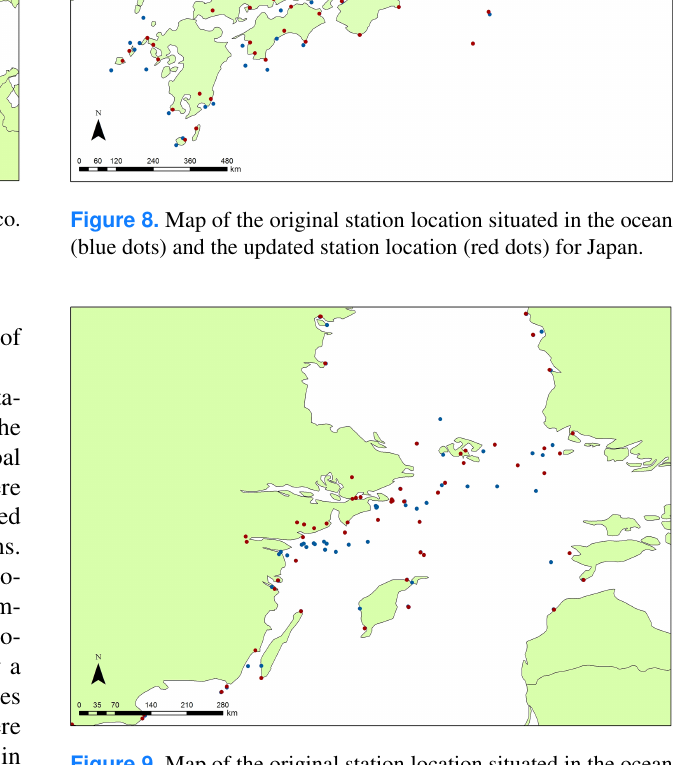
Figure 9. Map of the original station location situated in the ocean (blue dots) and the updated station location (red dots) for parts of northern